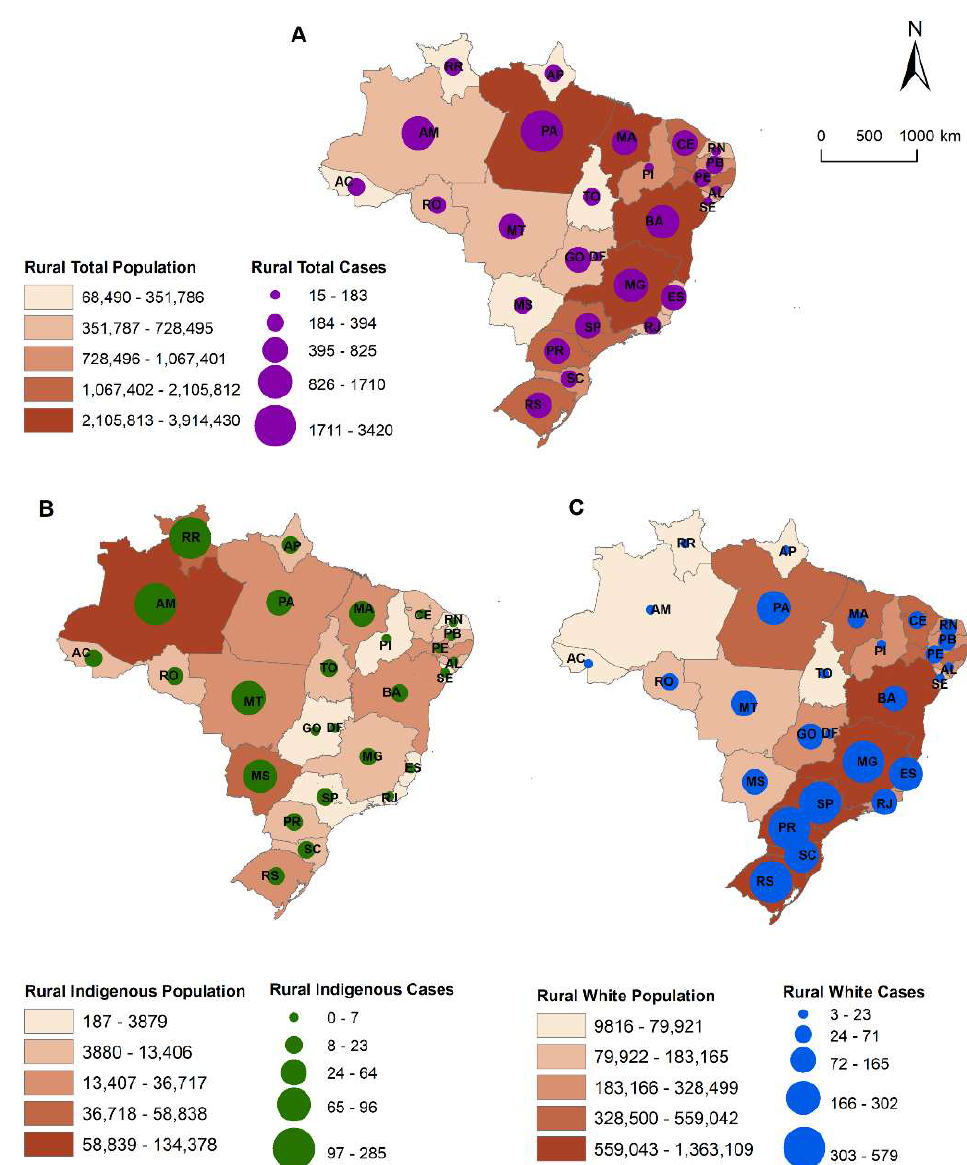
Figure 2. Number of total cases of snakebite ( A ), most exposed race group (indigenous) ( B ) and the less exposed (white) ( C ), rural population, by state, Brazil, 2017.